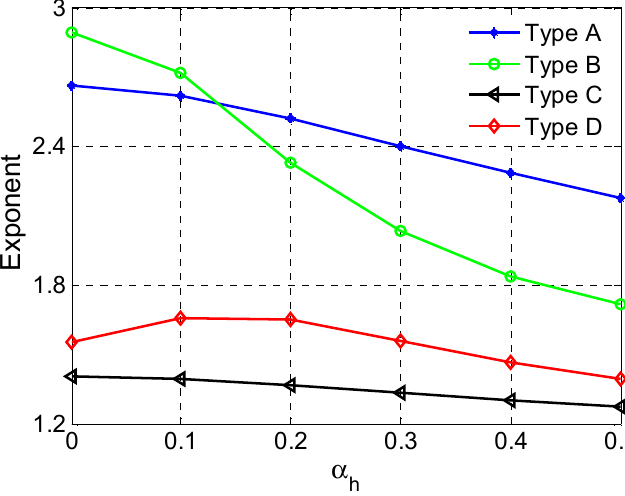
Figure 17. The dependence of the exponent e on the height ratio.